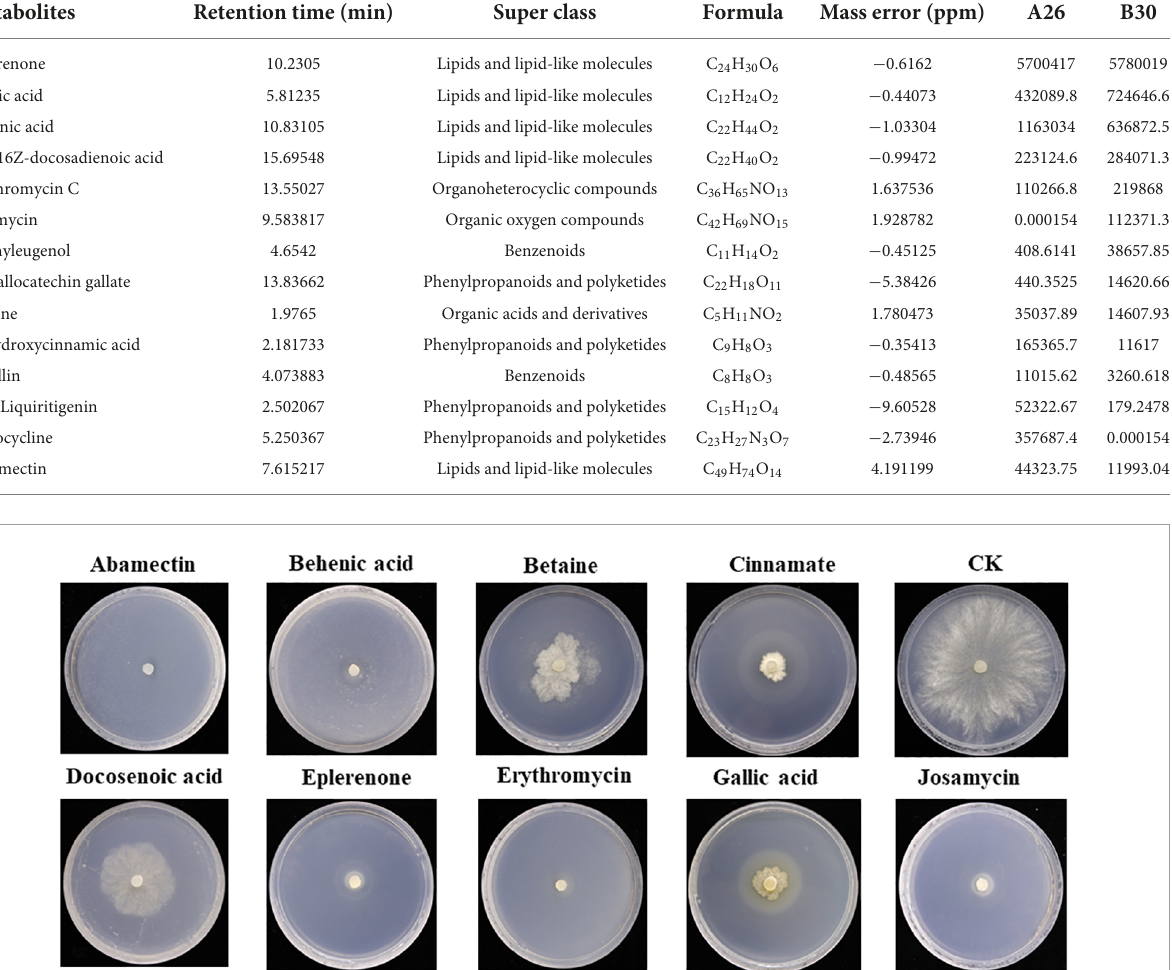
TABLE 6 Chemical formula, retention time, classification information, and peak values of chemicals.